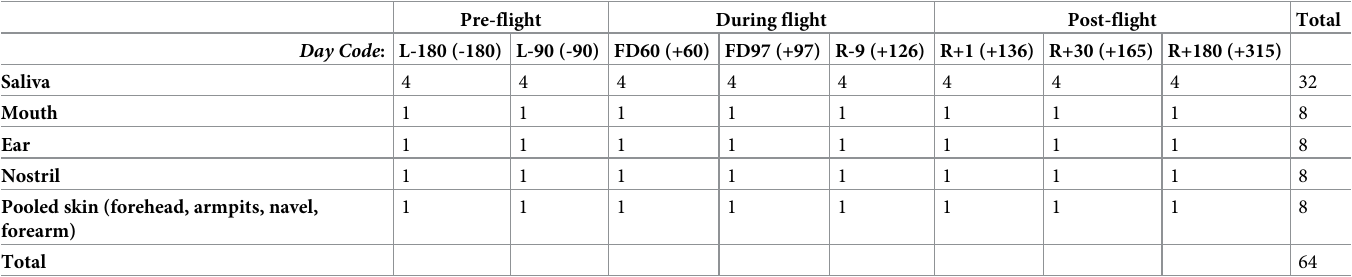
Table 1. Number of saliva and body swab samples from one crewmember. FD stands for Flight Day. L stands for Launch. R stands for Return. Crew member was aboard ISS during Flight